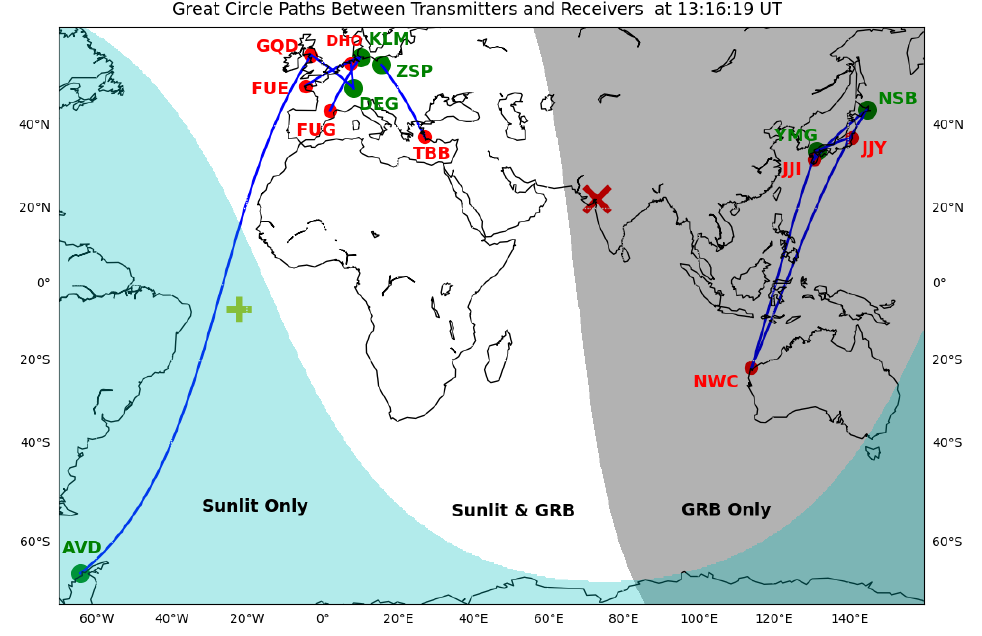
Figure 1. The geographical map shows the GCPs (blue) between VLF transmitters (red) and receiving stations (green). The areas lit by the GRB only, by the Sun and GRB, and by the Sun only are shown respectively. The sub-solar point of the Sun and sub-stellar point of the GRB are shown by the plus (green) and cross (red)